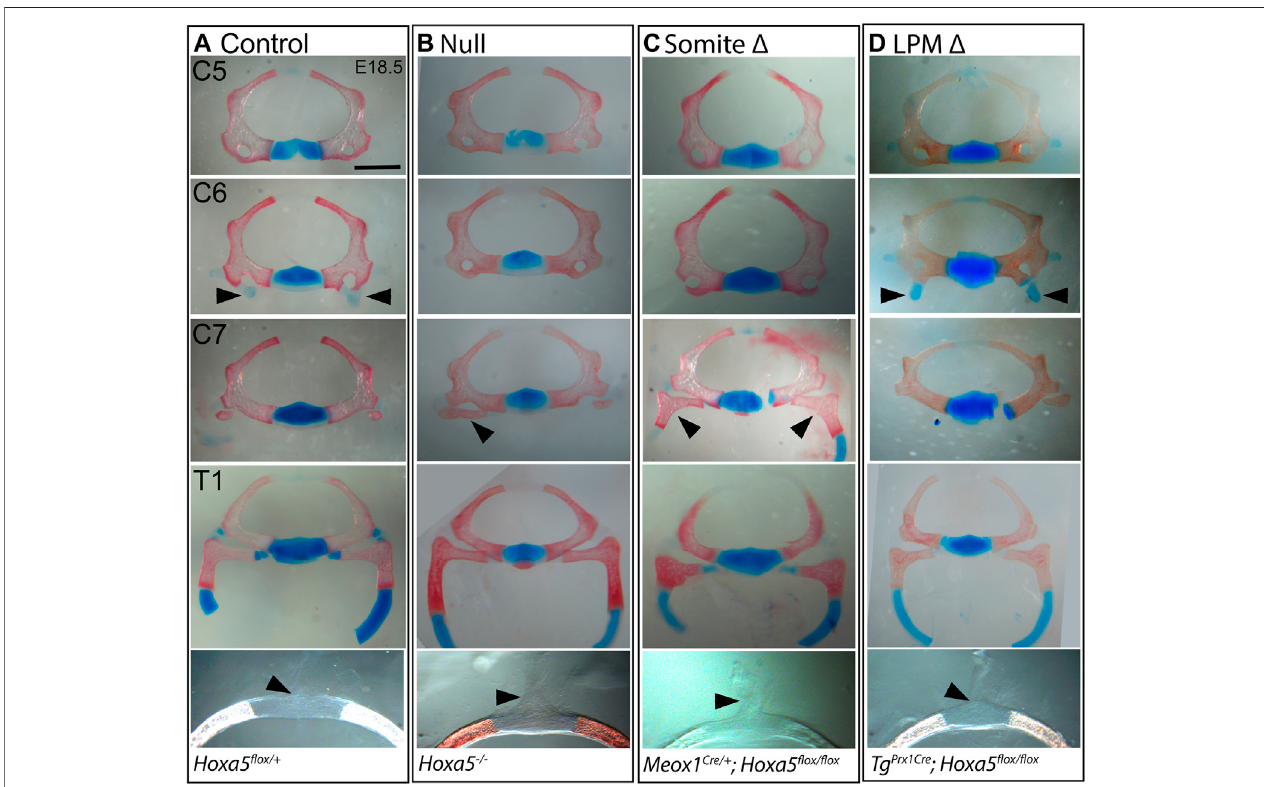
FIGURE 2 | Vertebral phenotypes associated with conditional Hoxa5 deletion at E18.5. Alcian blue and Alizarin red staining of vertebrae from control (A) , null (B) , somite deleted (C) , and LPM-deleted (D) embryos. Arrowheads indicate tuberculum anterior (TA) on C6, ribs on C7 and the position of the dorsal process on T1 (absenceofadorsalprocessindicatedbyatiltedarrowhead).NotethattheT1ribshavebeencutwithinthecartilaginous,distalportionforphotography.Scalebar1 mm (top four rows) or 0.47 mm (bottom row).